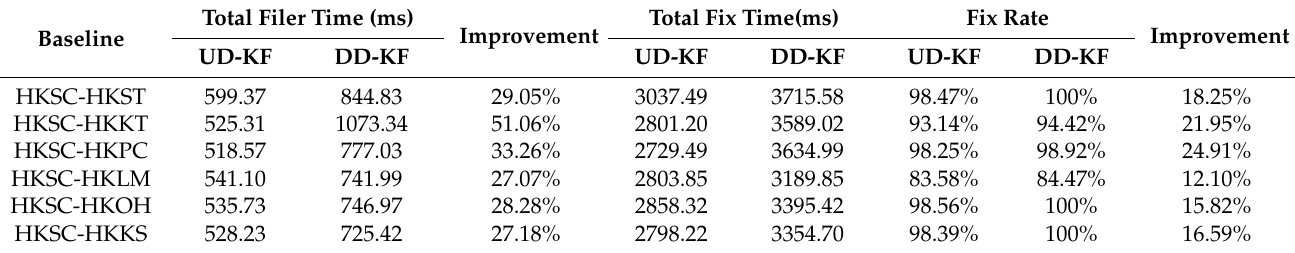
Table 5. Total time consumption statistics.